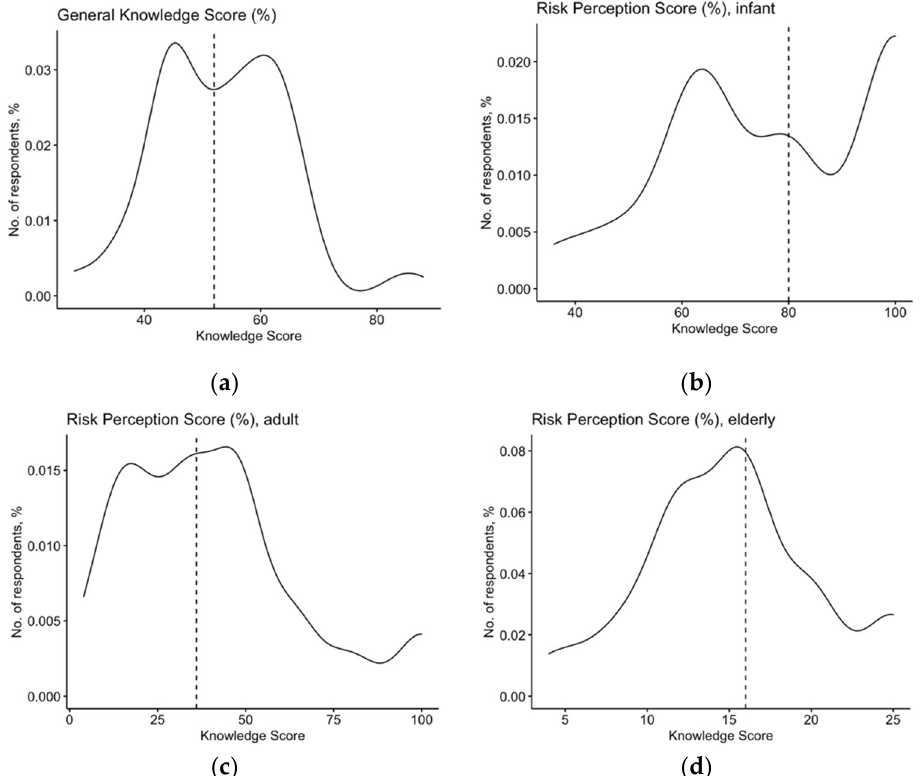
Figure 1. Density plot for general knowledge score ( a ) and risk perception score in infants ( b ), adults ( c ), and the elderly ( d ) in 157 Italian general practitioners participating into the survey. Cumulative scores were substantially skewed for GKS (D’Agostino–Pearson’s normality test: p = 0.054), and for